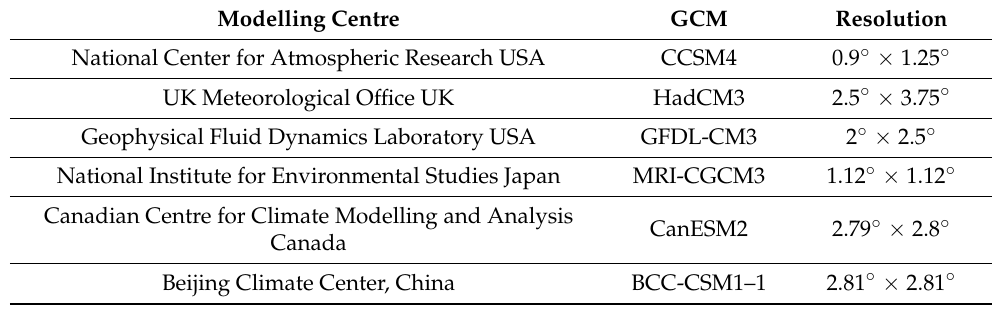
Table 2. Selected GCMs from CMIP5 used for downscaling techniques.